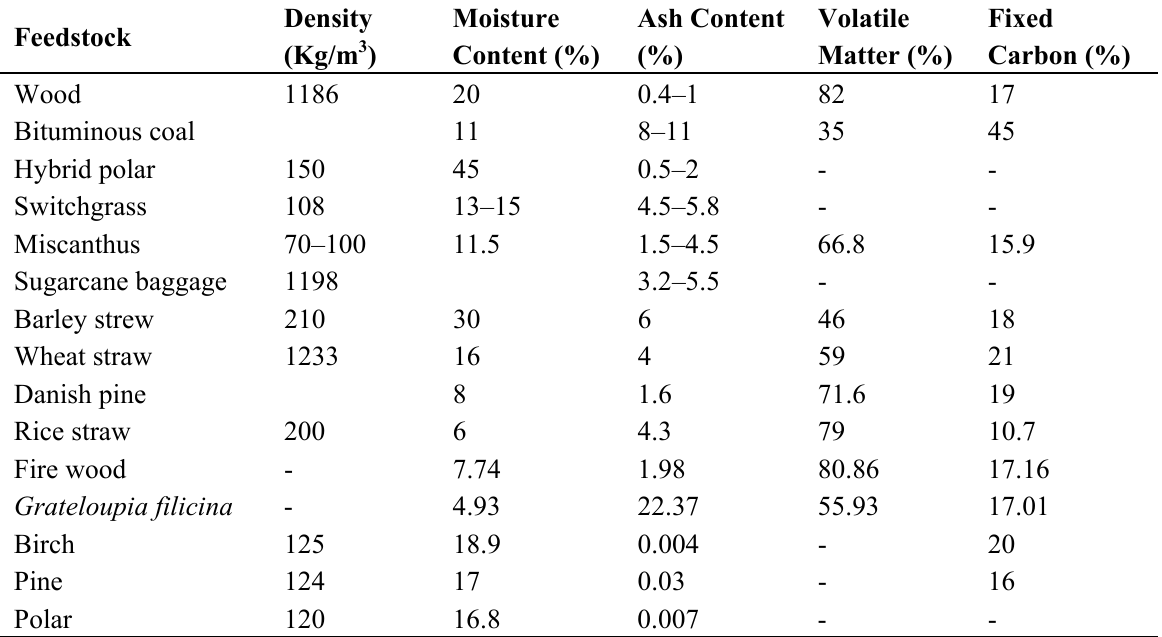
Table 4. Chemical characteristics of some selected biomass materials [48,55,66].